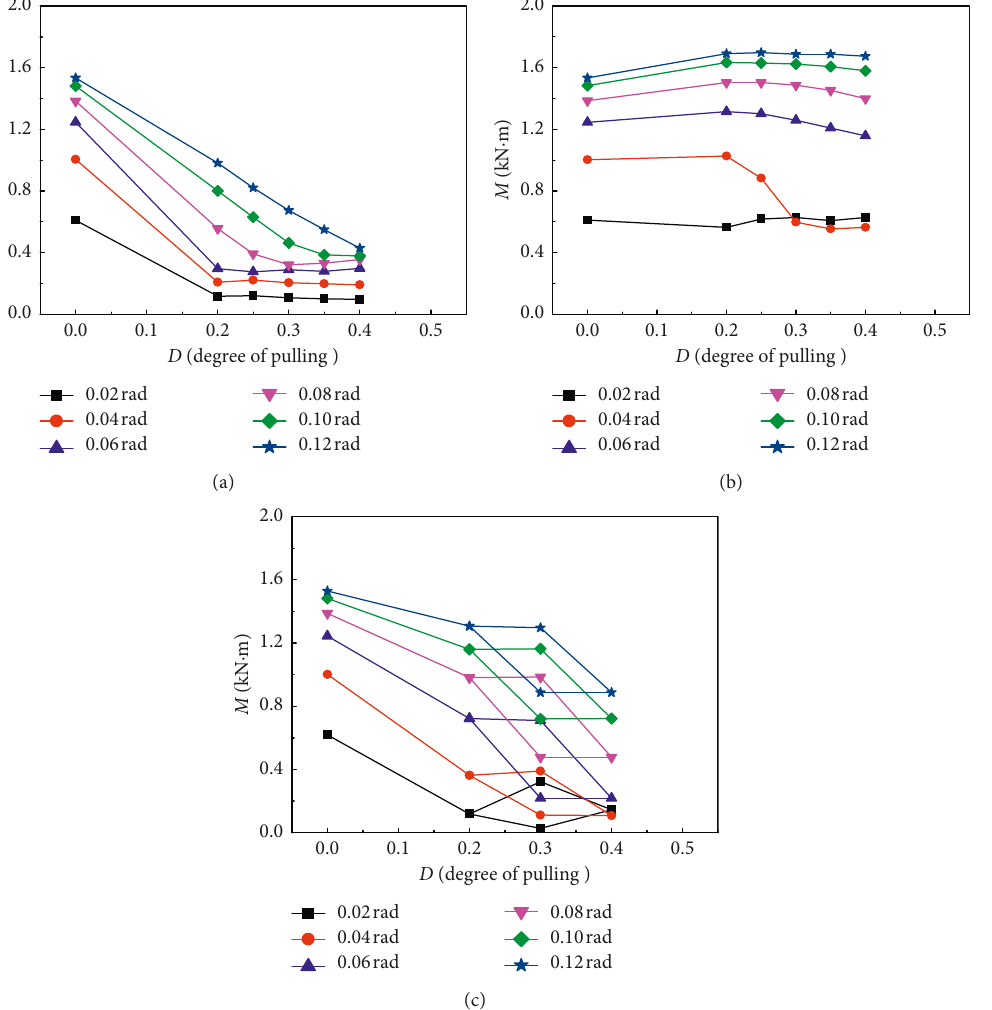
Figure 17: Relationship between bending moment and degree of slippage of the (a) pulling damaged frame, (b) contraction damaged frame, and (c) mixed damage